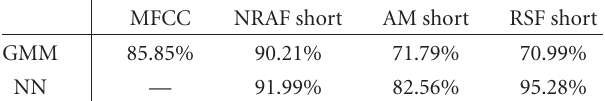
Table 1: Performance (% correct) for di ff erent features and di ff er- ent classifiers.